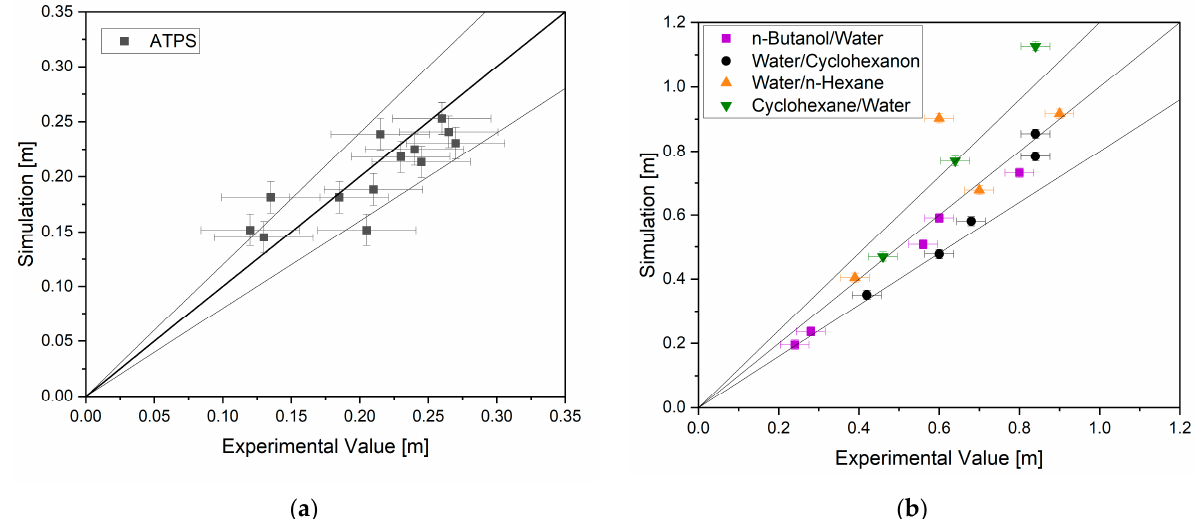
Figure 19. Representation of wedge length from experiments and simulations from ATPE ( a ), n-butanol/water, water/cyclohexanone, water/n-hexanes, and cyclohexane/water material systems ( b ).